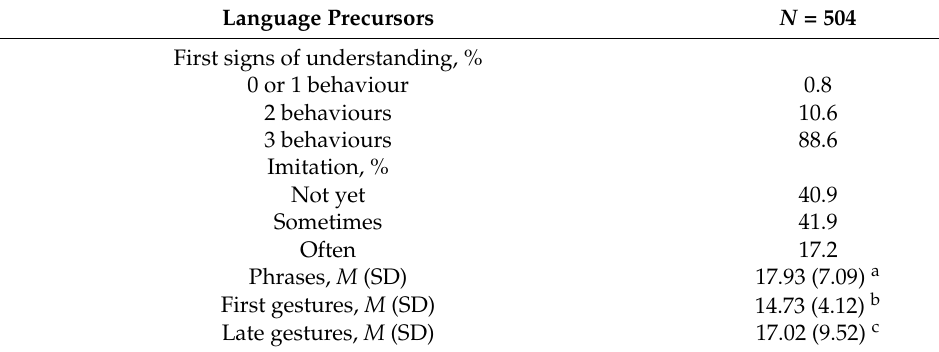
Table 2. Descriptive data on language precursors.